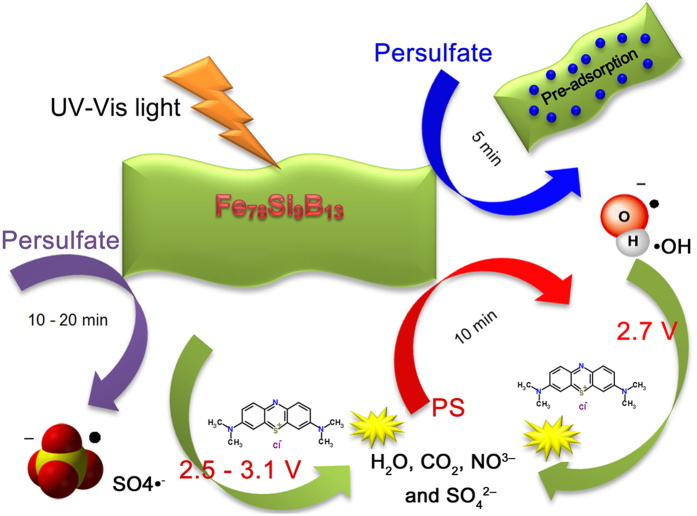
Amorphous Fe78Si9B13 alloy activation of persulfate and its dye degradation reaction.